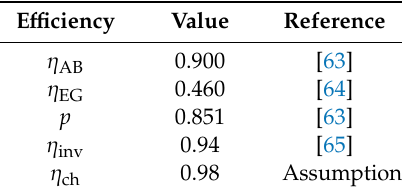
Table 3. Constant model